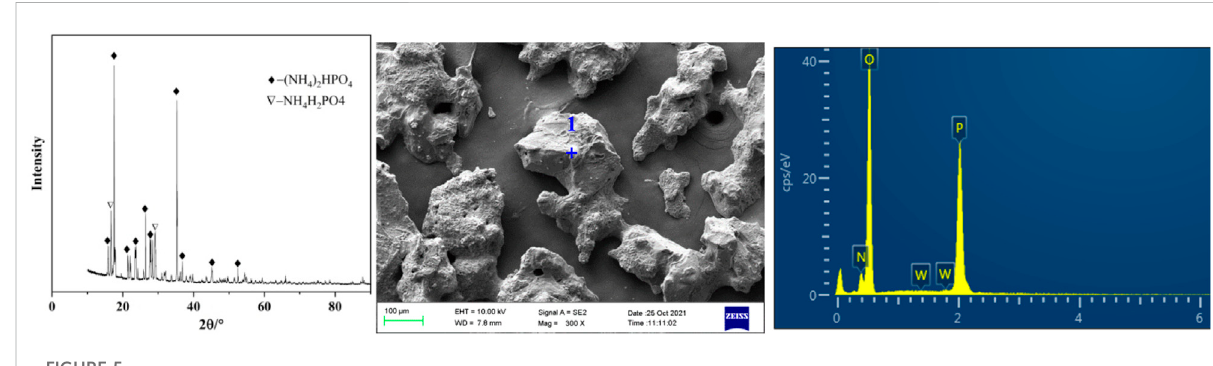
FIGURE 5 Phase analysis and microanalysis of precipitated